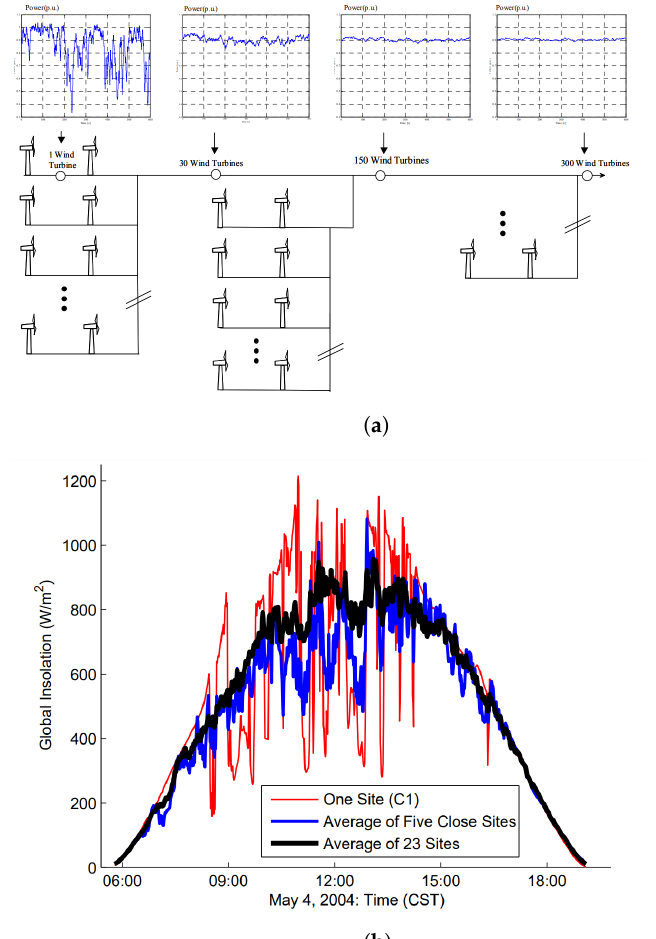
Figure 12. Effect of aggregating intermittent RES plants: ( a ) Wind turbines aggregation impact on the output power, reproduced with permission from Pedro Rosas [126]. ( b ) Impact of aggregating 5 and 23 PV power plants on GHI variations on a partly cloudy day, reproduced with permission from